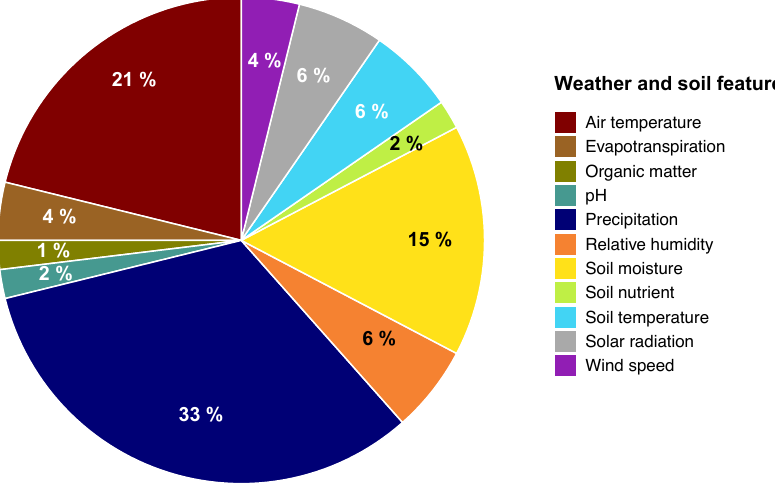
Figure 3. Distribution of weather and soil features for grass and forage prediction observed in selected literature.